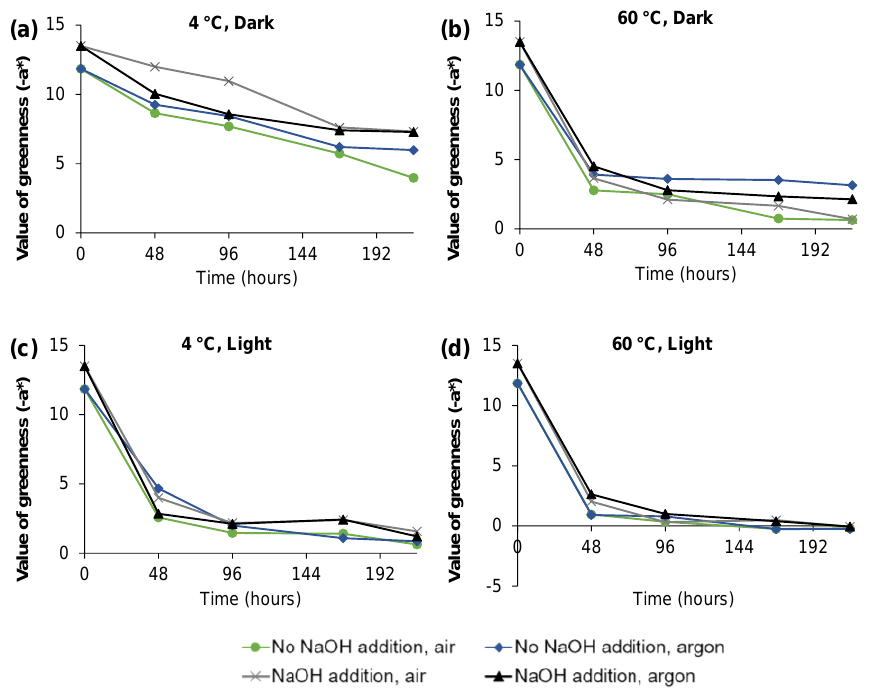
Figure 4. Value of greenness ( − a*) measured over time for the 16 experimental conditions ( a ) 4 °C, Dark, ( b ) 60 °C, Dark, ( c ) 4 °C, Light, ( d ) 60 °C, Light.